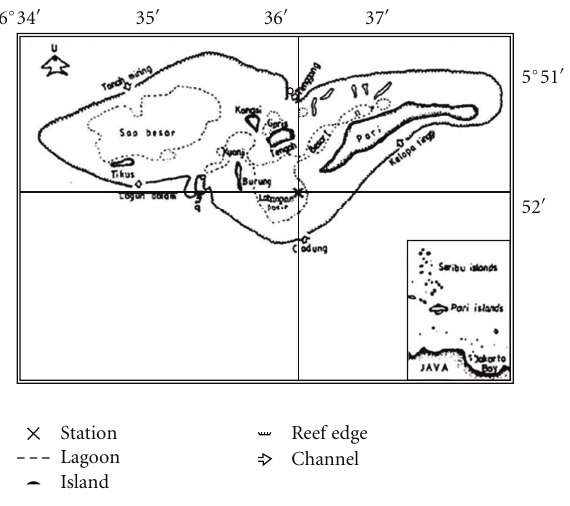
Figure 2: Map of Pulau Pari, Thousand Islands, North of Jakarta [30] the X marks the study site.